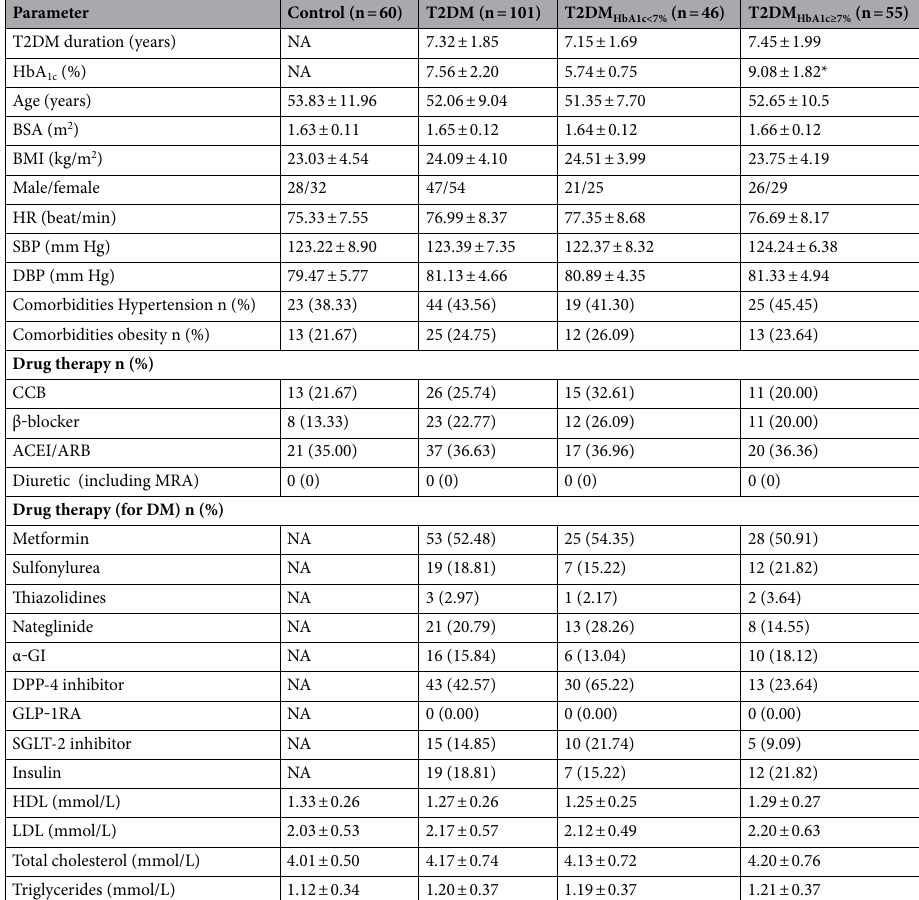
Table 1. Basic clinical data for all participants. Data are represented as the mean ± SD or as numbers. T2DM type 2 diabetes mellitus, HbA